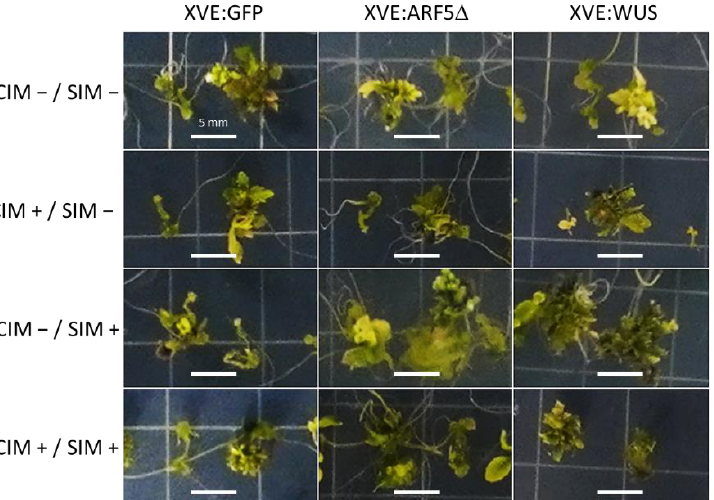
Figure 4. Morphology of shoot regeneration in plants expressing GFP , WUS, or ARF5 Δ . Root segments from one-week-old seedlings of plants carrying XVE:GFP, XVE:WUS, or XVE:ARF5 Δ were induced to form shoots by transfer to CIM for one week followed by transfer to SIM. Explants were transferred either to control ( − ) plates or plates supplemented with 0.1 µM β -estradiol (+). Two representative regenerating explants were imaged after four weeks on SIM. The scale bars represent 5 mm.